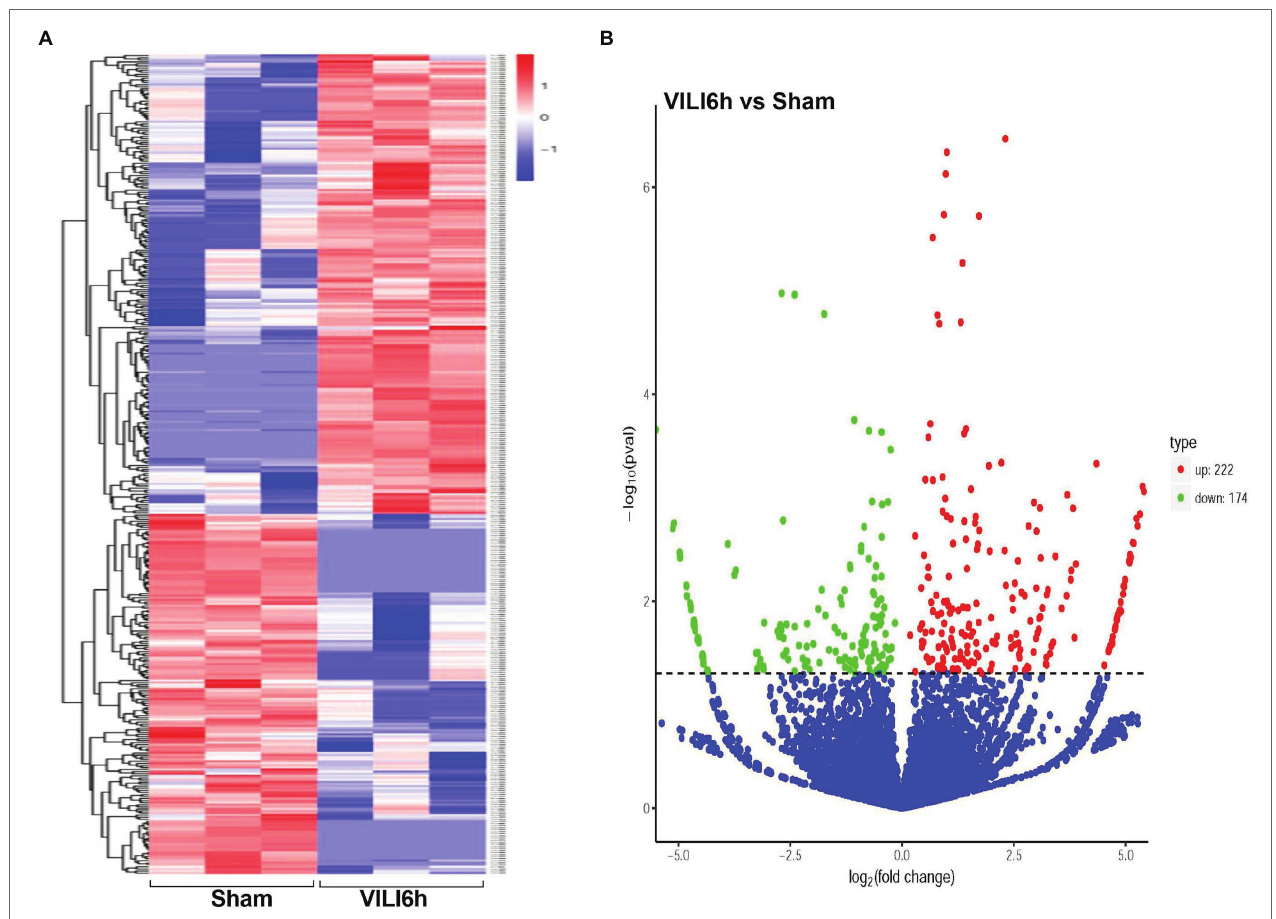
FIGURE 3 | Differentially expressed circRNAs between VILI 6 h and sham mice. (A) Heat map of the differentially expressed circRNAs in VILI 6 h and sham mice. The X-axis represents samples, and the Y-axis represents differentially expressed genes. The genes are clustered according to the degree of expression similarity on the left, and each sample is clustered according to the similarity of expression profiles at the top. The expression is gradually upregulated from blue to red, and the number is the relative expression after homogenization. The red and blue colors indicate upregulation and downregulation, respectively. (B) Volcano plot for the differentially expressed circRNAs in VILI 6 h and sham mice. The X-axis represents the fold change of circRNA expression (log2 Fold Change) in different groups, and the Y-axis represents the statistically significant degree of circRNA expression change. The scattered dots in the figure represent each circRNA, the blue dots represent the circRNAs with no significant difference, the red dots represent the differential circRNAs that are significantly upregulated, and the green dots represent the differential circRNAs that are significantly downregulated. The dotted line represents p = 0.05. VILI. Ventilator-induced lung